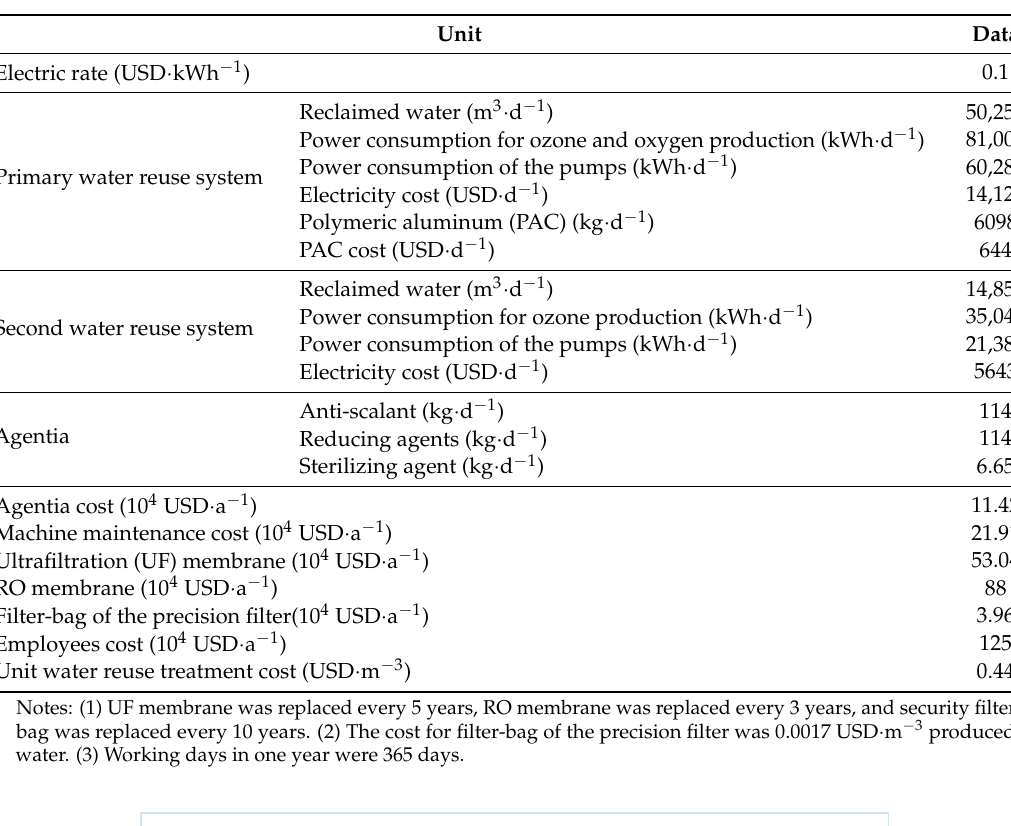
Table 6. Operating cost of the combined process.